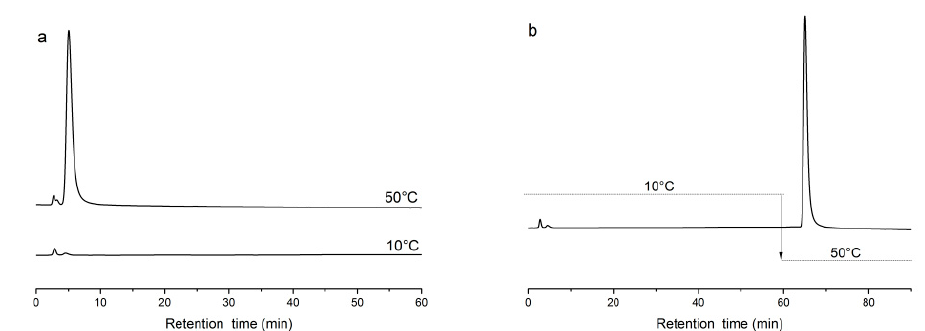
Figure 7. Chromatograms of adenosine using a poly(NIPAAm- co -DMAEMA- co -VPBA)-grafted silica column. ( a ) Chromatogram of adenosine at 10 and 50 °C; ( b ) injecting the sample at 10 °C and changing the temperature to 50 °C at 60 min, flow rate 0.1 mL/min, detection wavelength 280 nm, sample size 5 μ L.